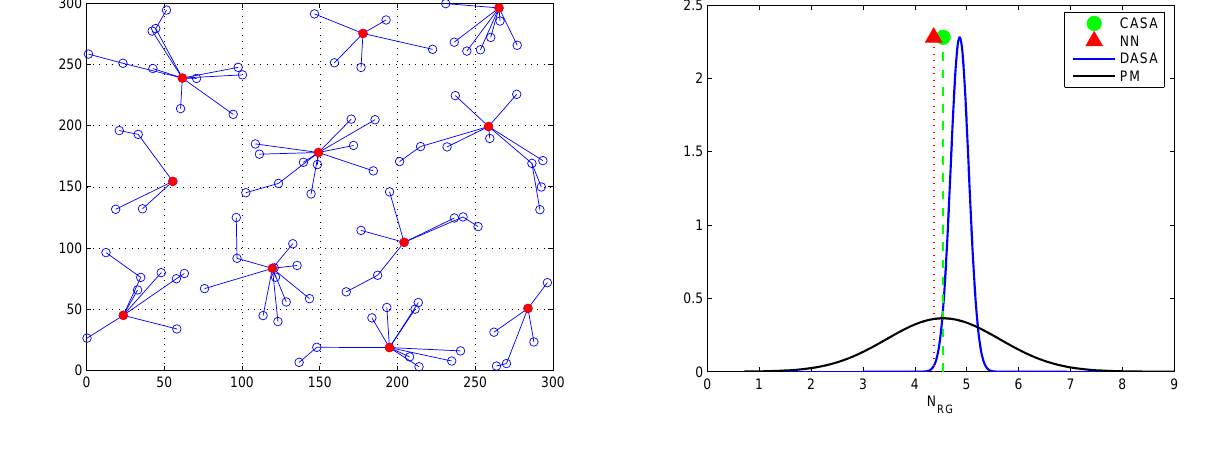
applying the proposed RG = 100 s